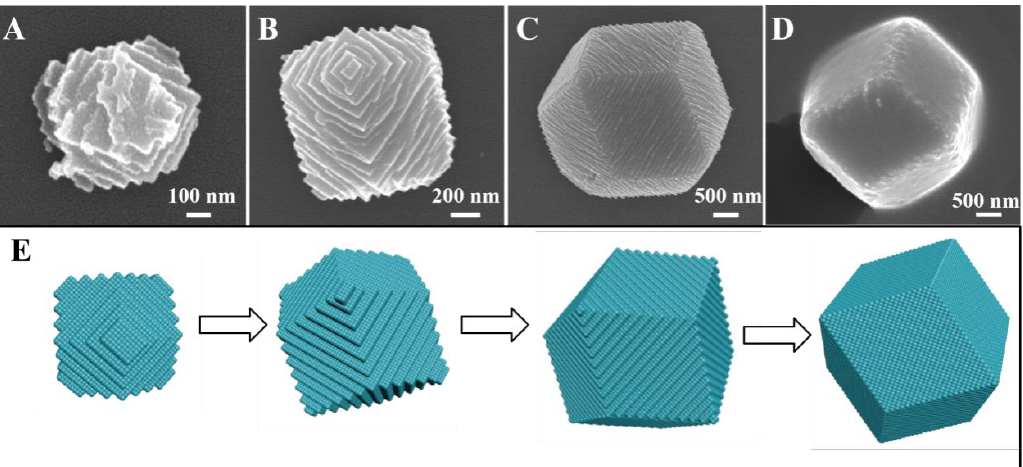
Figure 5. SEM images of HSANs prepared from ( A ) 20 min; ( B ) 30 min; ( C ) 60 min; ( D ) 95 min UV-irradiation. ( E ) Concentration of AgNO 3 precursor: 5 M.